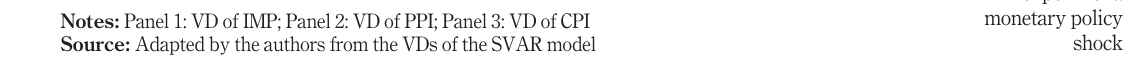
Table IV. VD results;